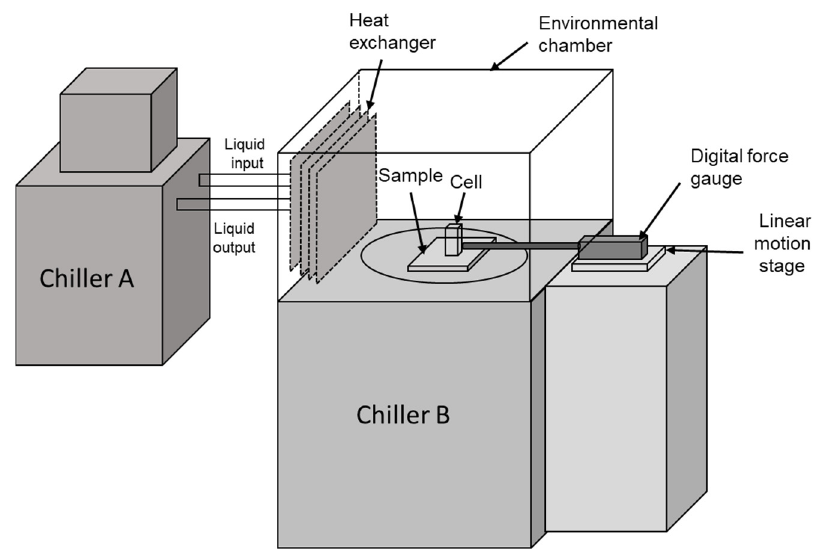
Figure 1. Schematic of the cooling chamber used for ice adhesion strength measure- ments.